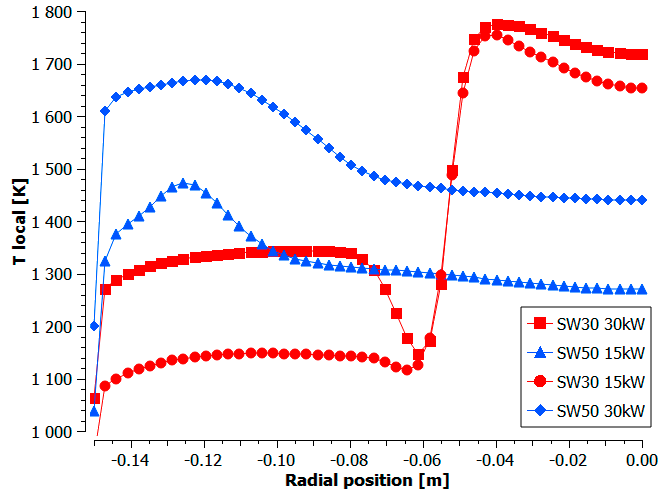
Figure 8. Comparison of the local temperature distribution for different swirlers and thermal load, 3D modelling, Xiao, axial position 30 mm, φ = 0.71.